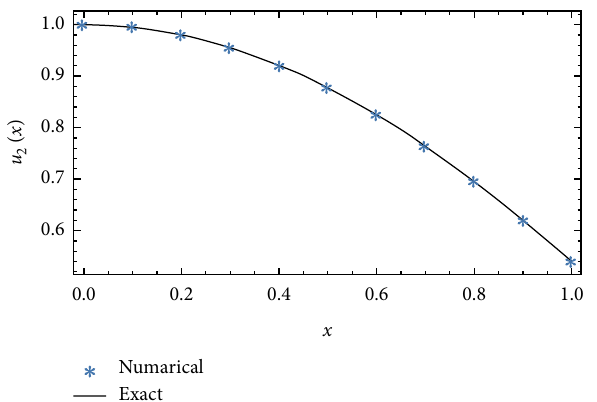
Figure 5: The exact and numerical solutions of for system